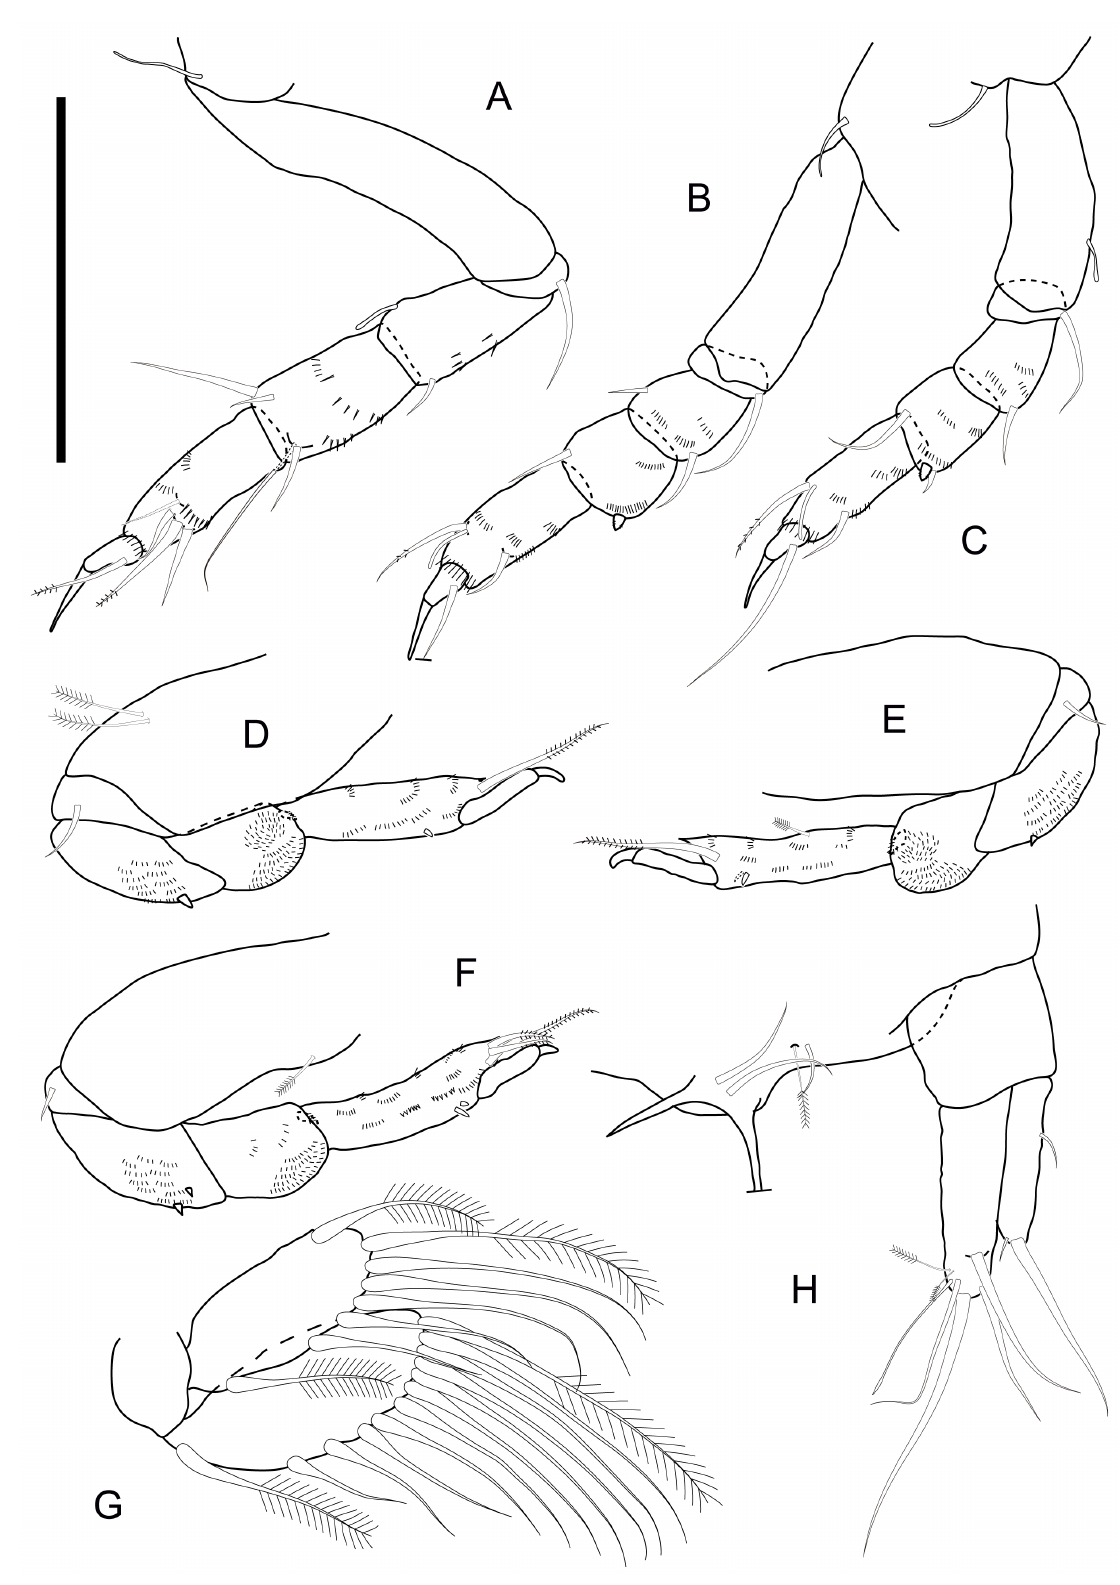
Fig. 16. Typhlotanais priscilae sp. nov., ♀, dissected (MZUSP 38009). A–F . Pereopods 1–6. G . Pleopod. H . Uropod. Scale bar = 0.1